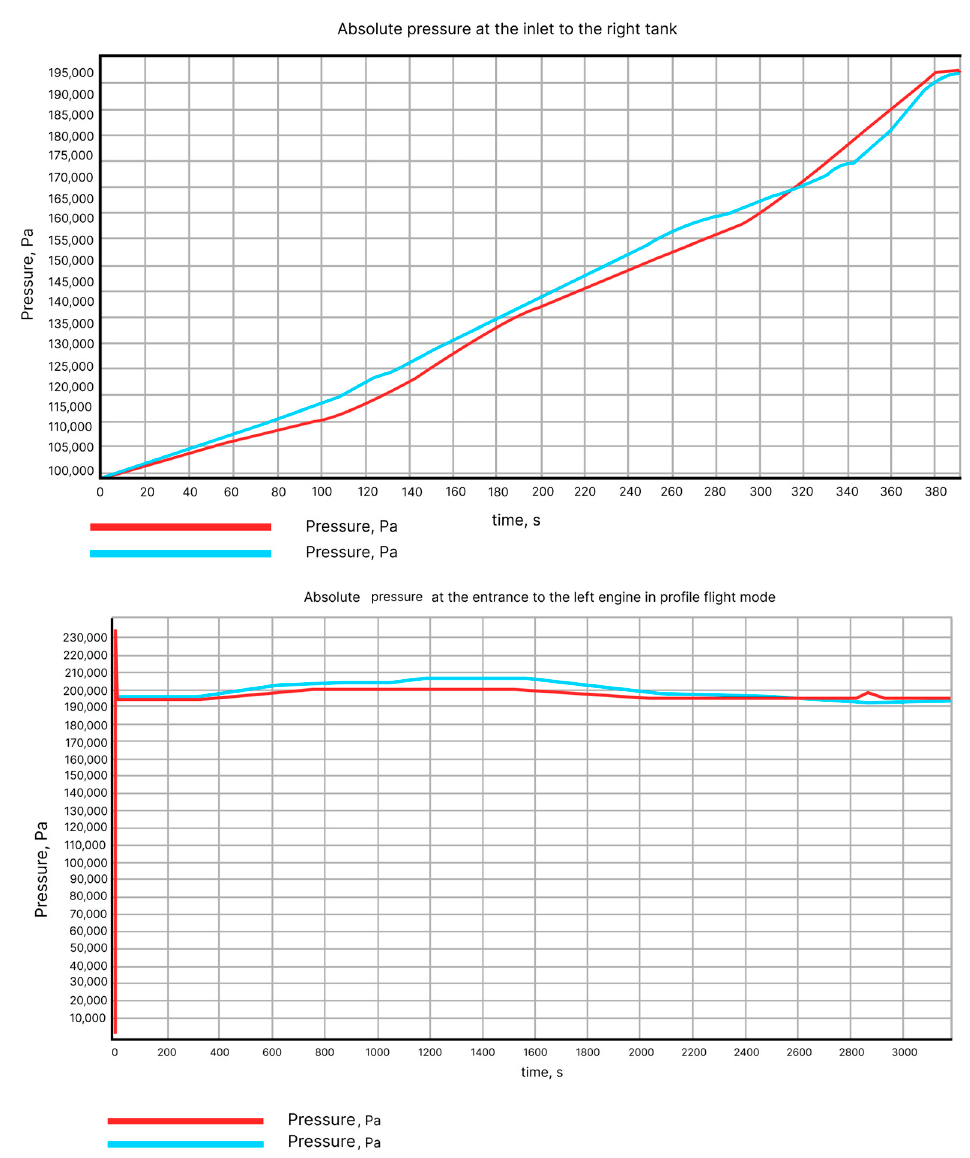
Figure 10. Absolute pressure at an inlet to left engine under refueling and profile flight modes.